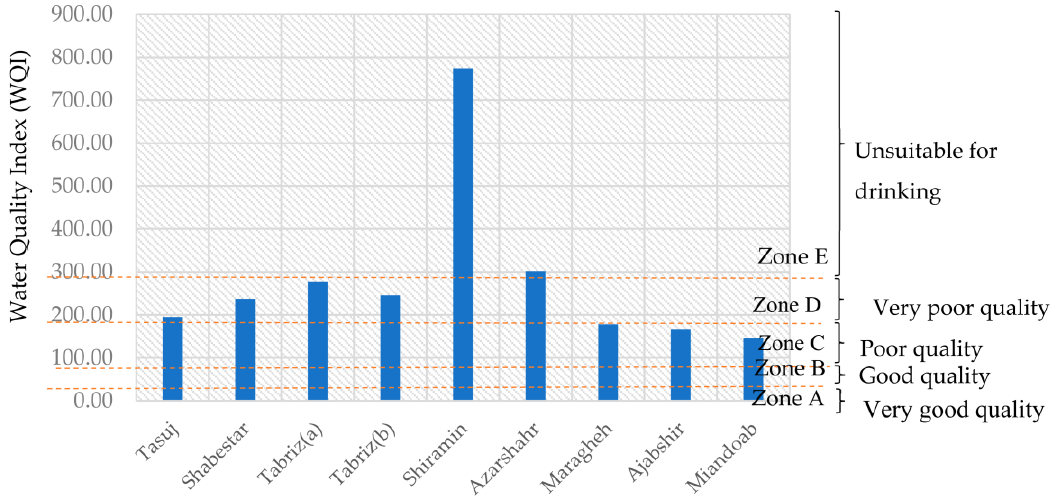
Figure 6. Water quality status in the aquifers of the study